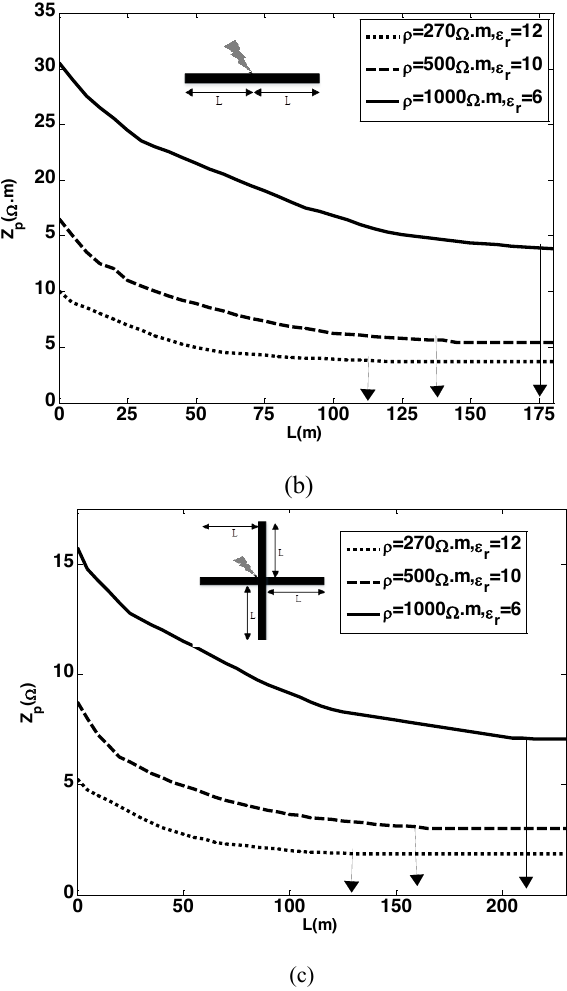
Figure 8: Impulse impedance of (a): corner-fed electrode, (b): center-fed two-arm electrode, and (c): center-fed four-arm electrode for the three lossy